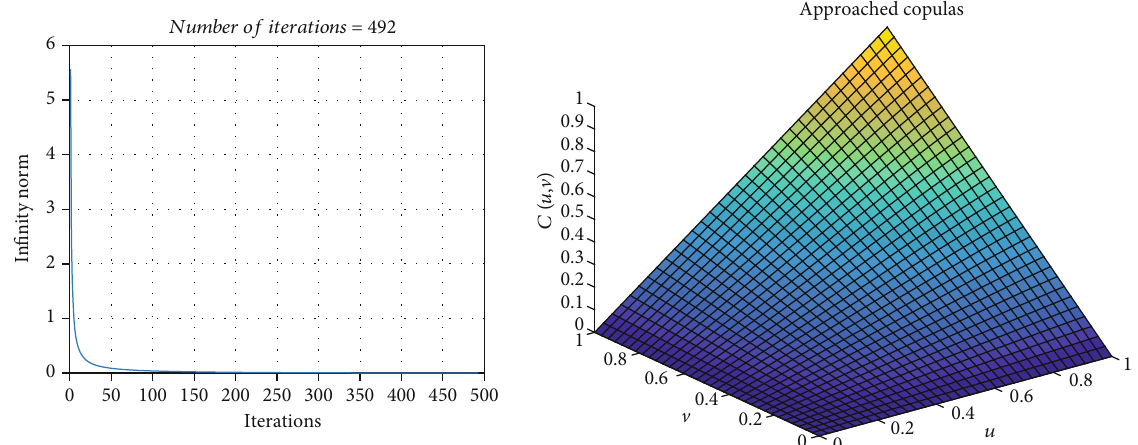
Figure 5: Approached solution of fi nite di ff erence method when N = 32, h = 1/33 , and k = 0 .